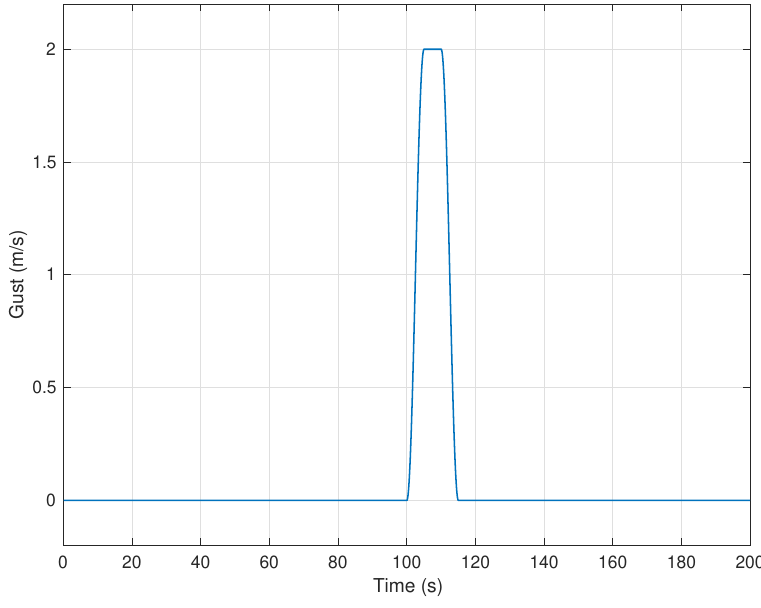
Figure 3. The gust disturbance.